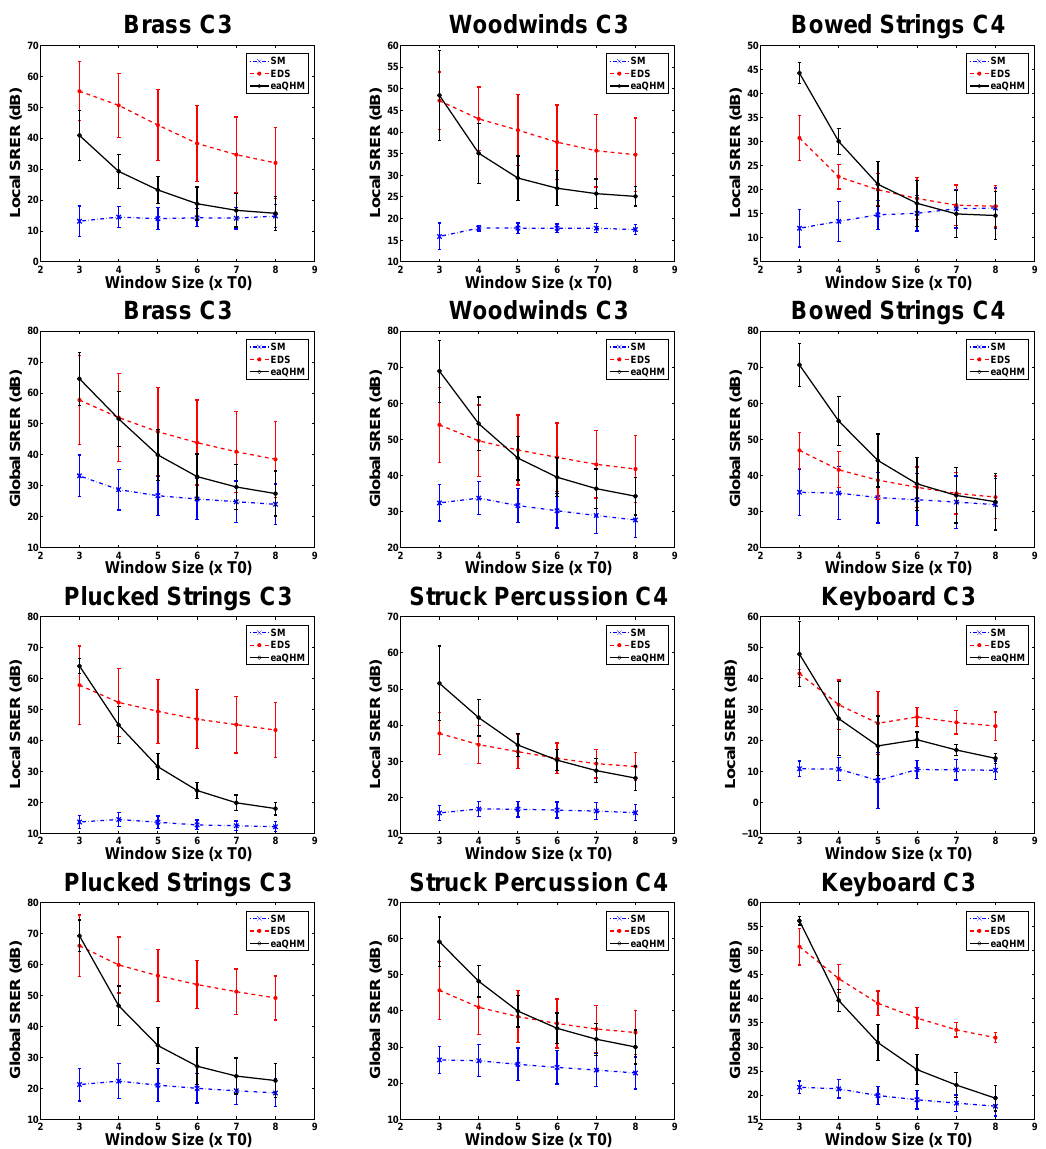
Figure 6. Comparison between local and global SRER as a function of the size of the frame for the three models (SM, EDS, and eaQHM). The bars around the mean are the standard deviation across different sounds from the family indicated. The distributions are not symmetrical as suggested by the